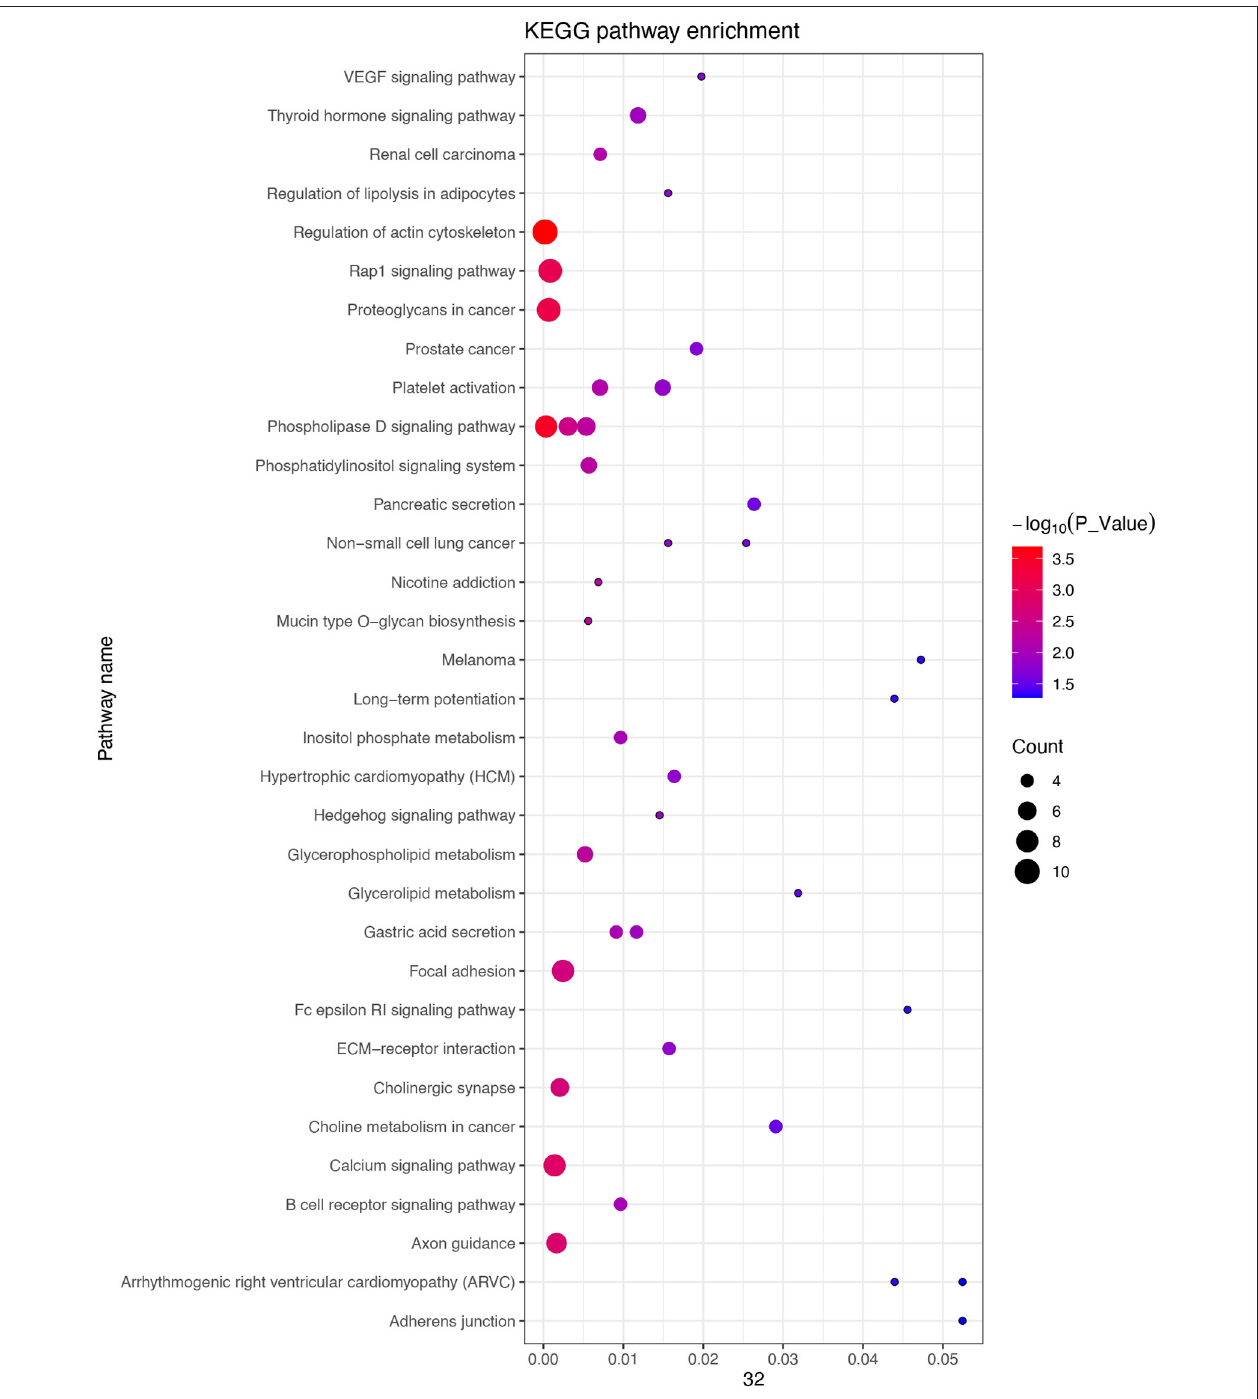
FIGURE 4 | Kyoto Encyclopedia of Genes and Genomes (KEGG) enrichment analysis for the regional candidate genes with the chromosome-wide significant